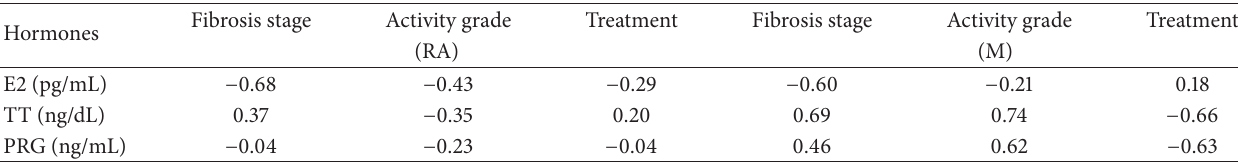
Table 5: The correlations between hormonal levels in reproductive aged and menopausal patients and the fibrosis stage, activity grade, and virological response. Hormones